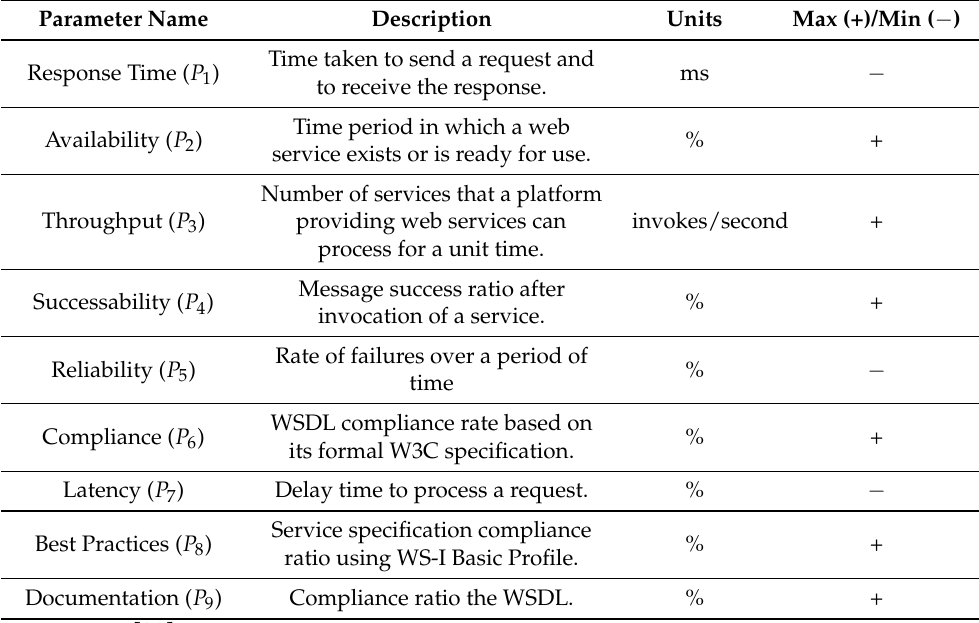
Table 1. QoS parameter description for WS selection.